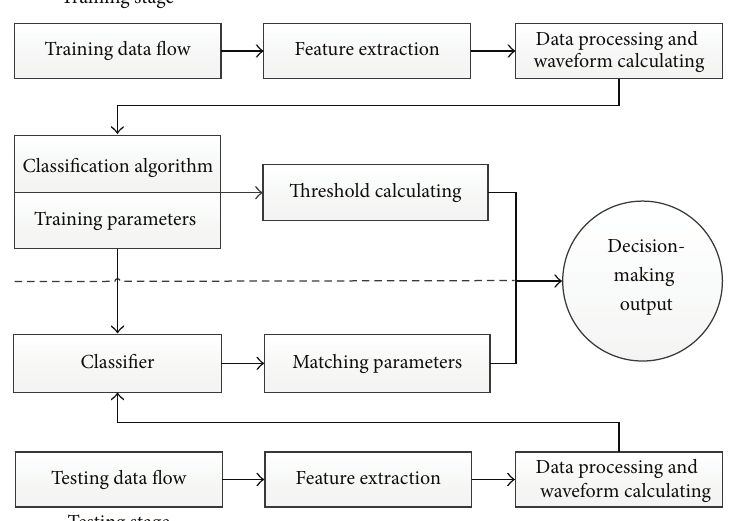
Figure 2: System